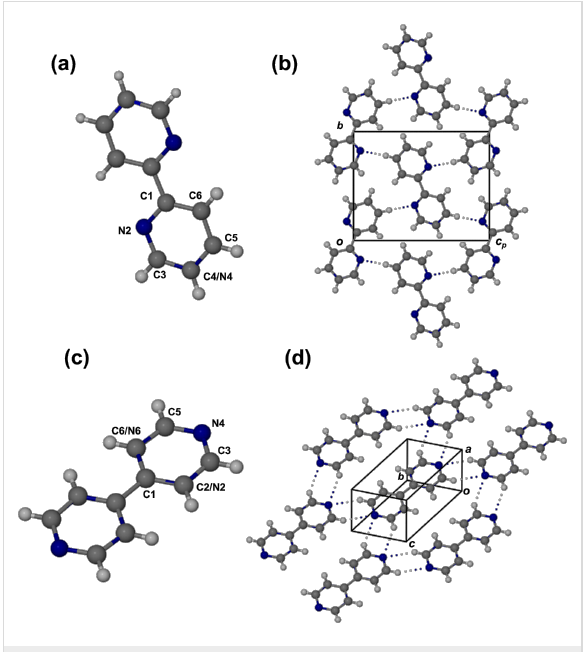
Figure 4: Molecular and crystal structures of 6 (a,b) and 8 (c,d). The molecules are located on centers of inversion and their asymmetric units are labelled, disordered atoms being indicated as C n /N n